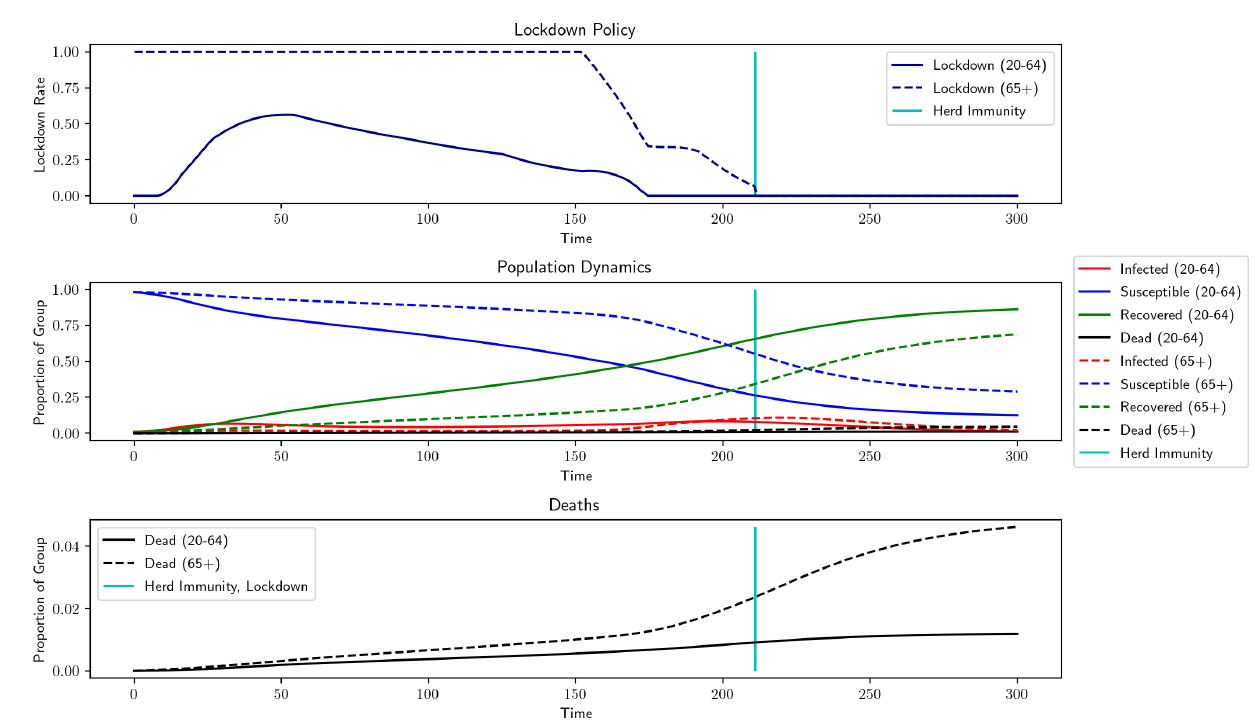
Figure 3. Proposed model (two groups, herd immunity); parameters from Table A1. Herd immunity: 211 d, output loss: 7.8767%, total deaths: